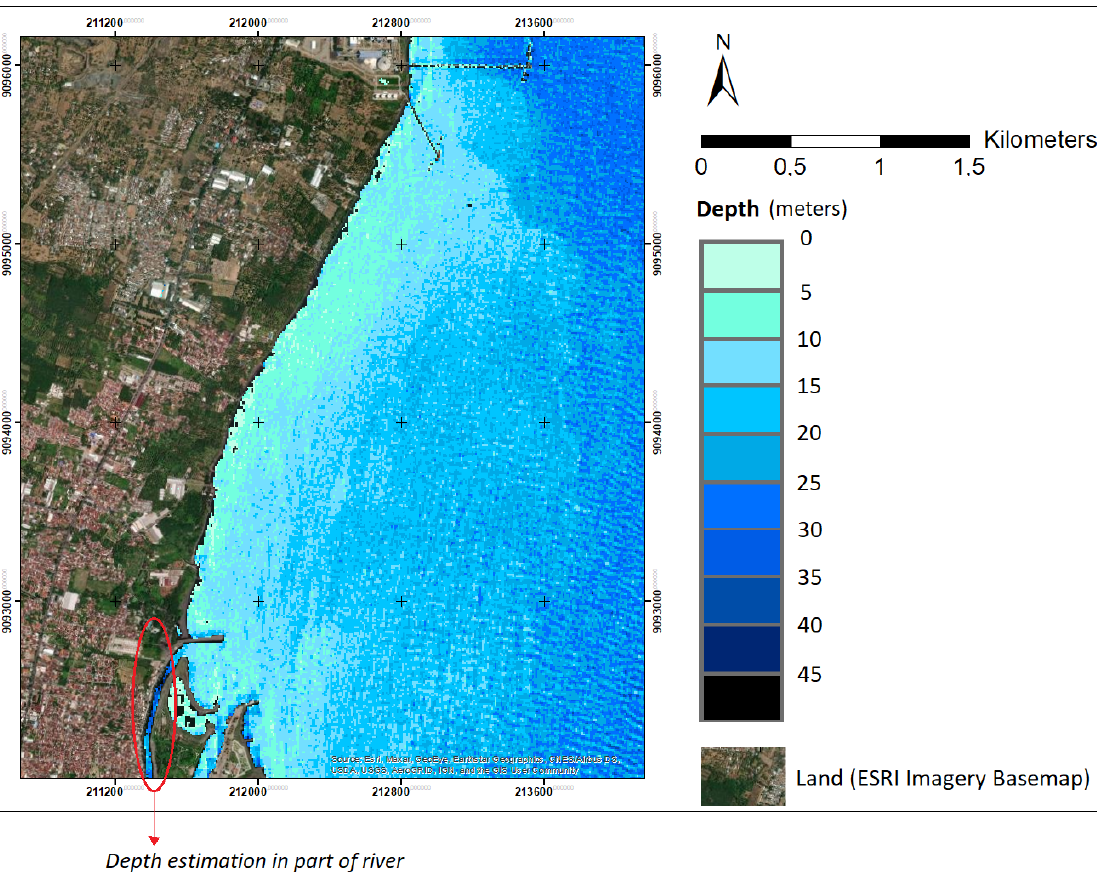
Figure 3 . Water Depth Estimation Result from SDB, Band 1 and Band 3 Combination.